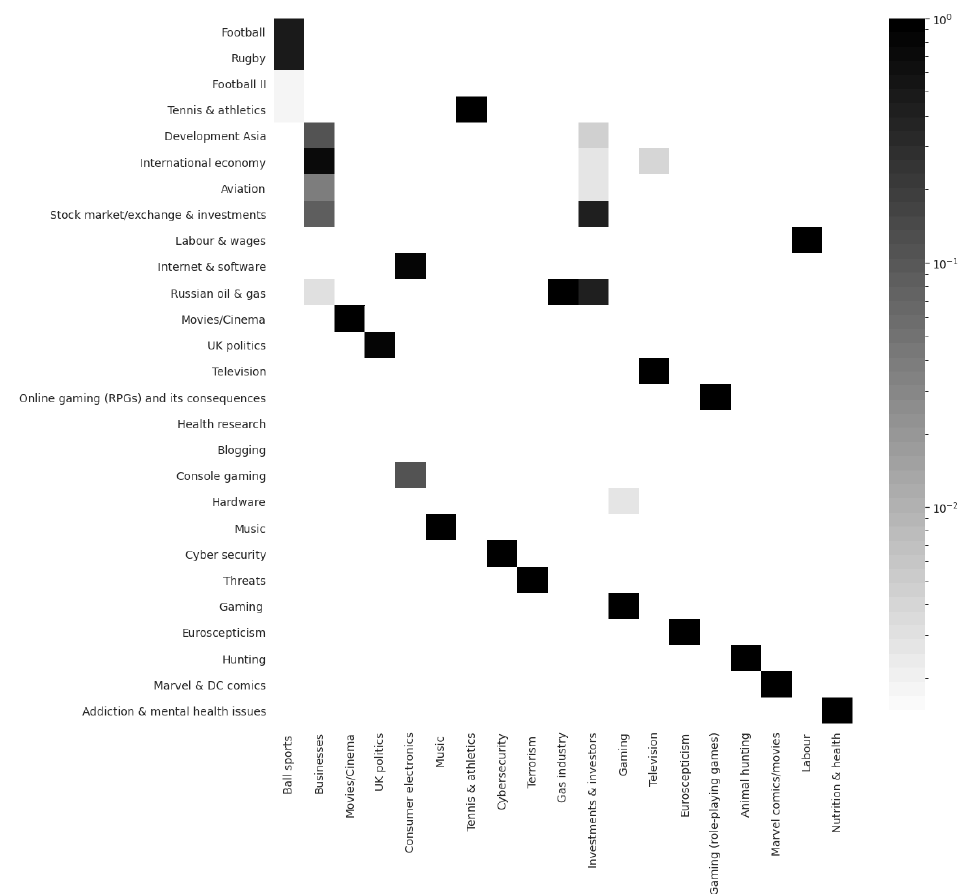
Figure 4. Heat map showing how topic terms of the 19 γ = 1.37 topics (columns) get distributed on 27 topics at γ = 1.5